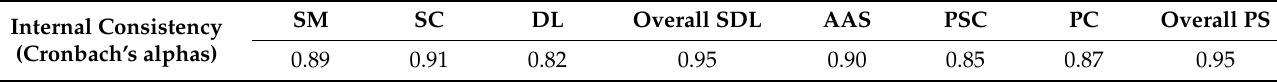
Table 2. The results of the internal consistence of the SLDR and